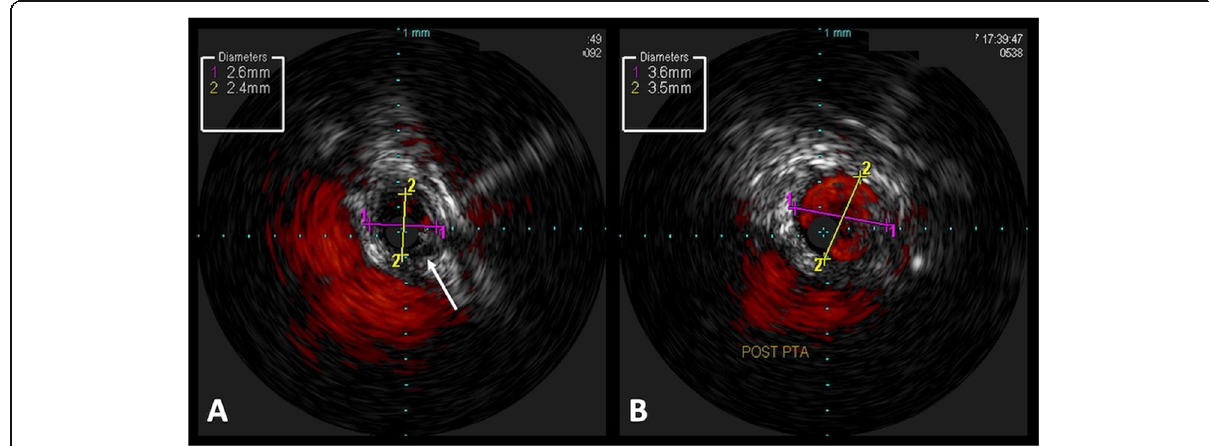
Fig. 2 Intravascular ultrasound. a IVUS image of severe right renal artery origin stenosis with mural thickening consistent with FMD. b Post